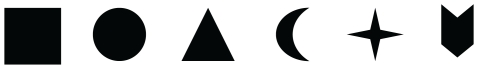
The six distinct shapes used in Experiment 4.